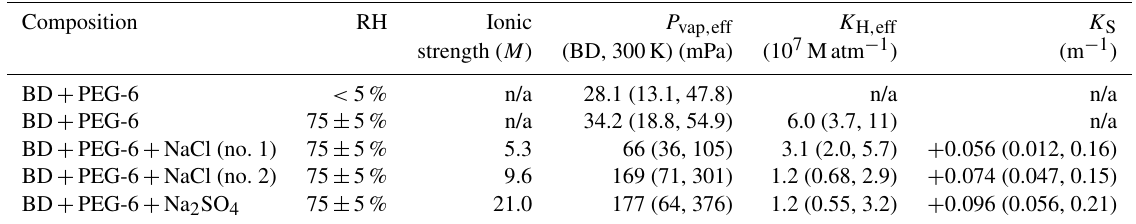
Table 3. Extracted effective vapor pressures P vap , eff for butenedial (BD) with 95% confidence interval bounds (given within parentheses) obtained from uncertainties in model input parameters described in the main text, along with effective Henry’s law constants K H , eff and Setschenow constants K S , where applicable. Uncertainties in K H , eff and K S derived from propagating uncertainties in associated P vap , eff values. Values not applicable to particular compositions are marked